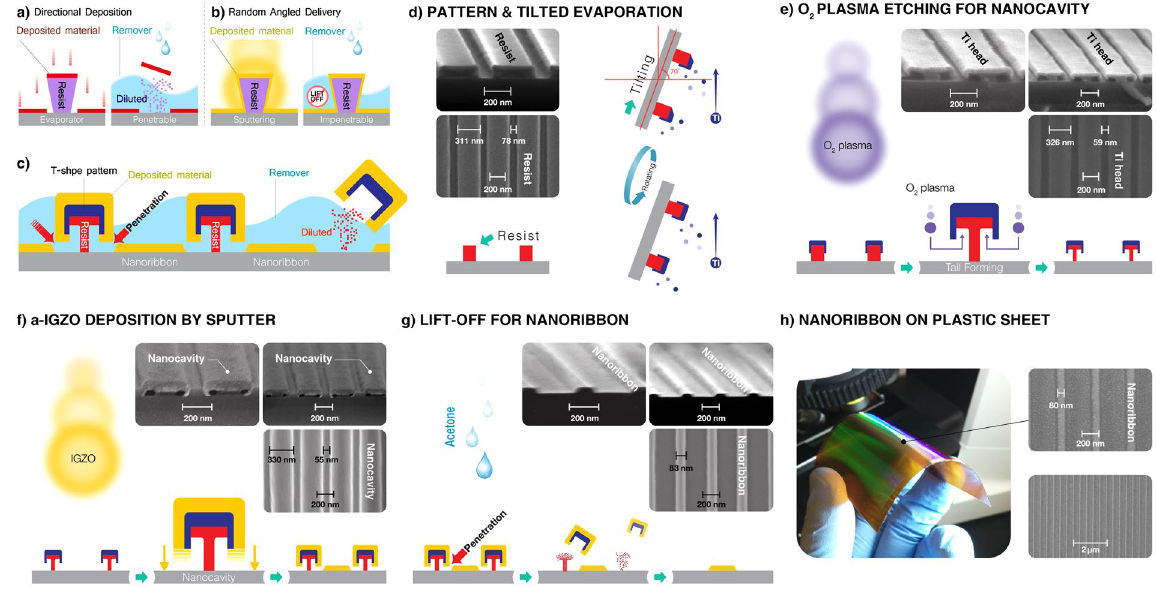
Figure 2. Procedures for a-IGZO NRs fabrication by lift-off. ( a ) Schematics of typical lift-off based on evaporation systems. The undercut area of the resist is not covered by directional deposition of material. ( b ) Challenges in lift-off of randomly angled sputtered films. The undercut area of the resist is covered by deposited material so solvent cannot react with the resist during the lift-off process. ( c ) The lift-off procedure based on T-shape pattern. ( d – g ) Cross sectional diagram and SEM images of lift-off NRs fabrication step. ( d ) Imprinted grating patterns from master stamp with 400 nm pitch, 70 nm spaces, and 120 nm height; and Ti hard mask formation by tilted depositions. ( e ) Tail creation on edge of resist by O 2 ashing process. ( f ) a-IGZO deposition of 45 nm by sputtering on the lift-off patterns. ( g ) performing lift-off process using acetone. ( h ) Photograph and plan-view SEM images of the produced the same size of NR on PI substrate.